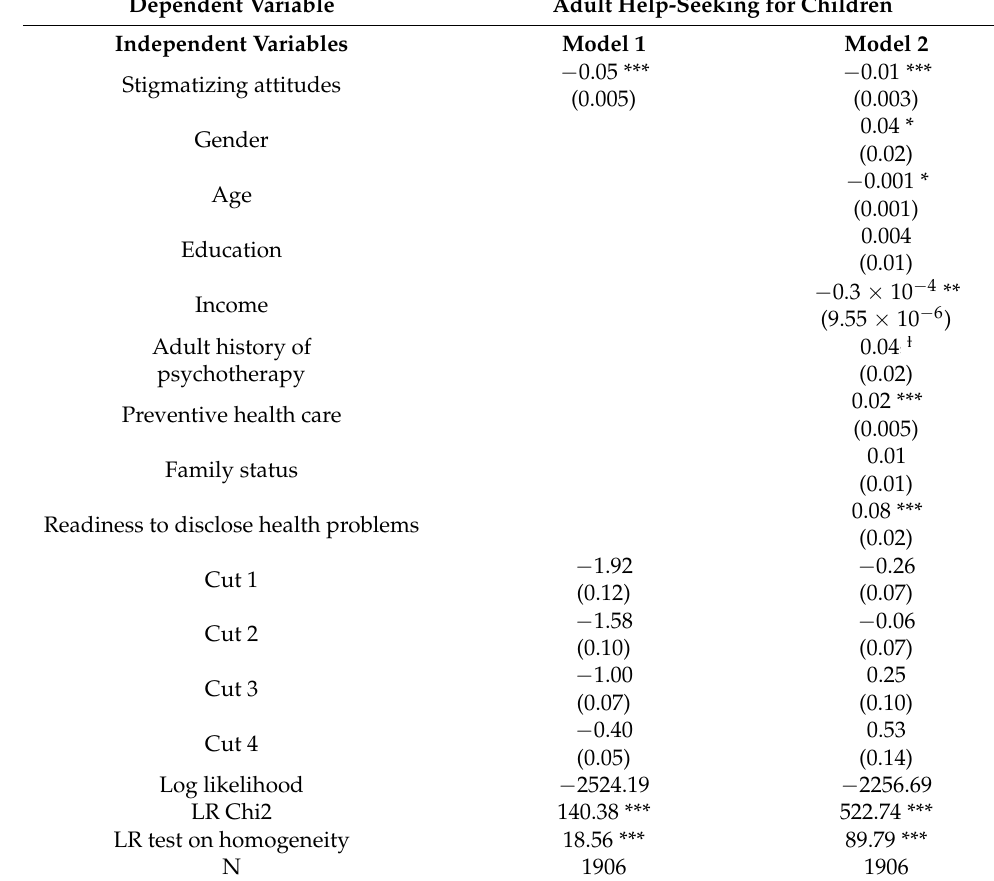
Table 3. Table 3. Results from the heteroscedastic ordered probit model. Notes: ƚ p < 0.1; * p < 0.05; ** p < 0.01; *** p < Table 3. Results from the heteroscedastic ordered probit model. Notes: